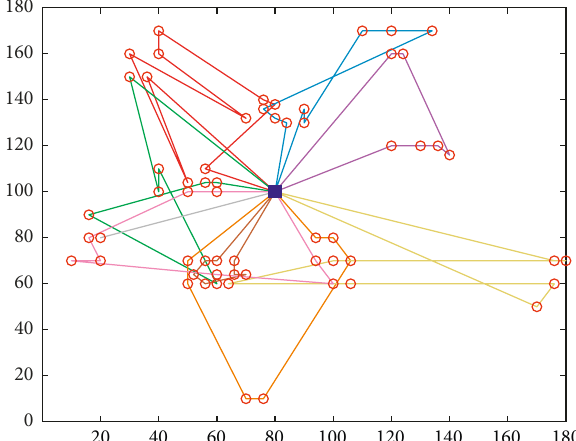
Figure 9: Optimal route for the simulated annealing-genetic hy- brid